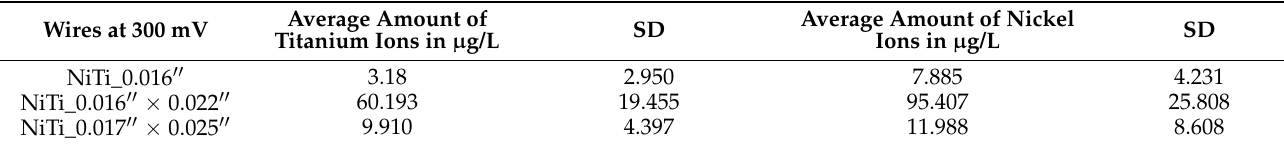
Table 10. The average amount of Ti and Ni ions being measured when 300 mV was applied on the three different dimensions of the NiTi wires.